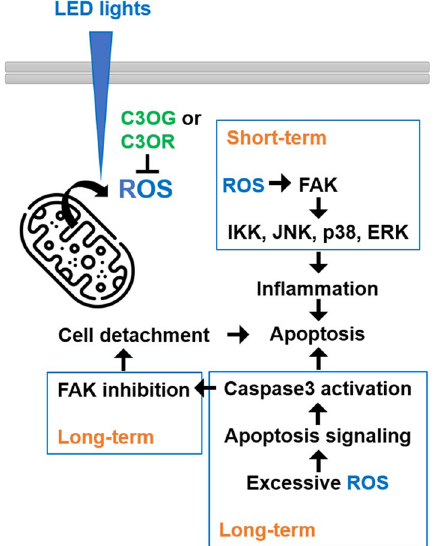
Fig. 7 C3OG and C3OR block blue light‑induced cytotoxicity. Exposure to blue light initiates FAK‑related inflammation signaling events via ROS, triggering apoptotic signaling. Treatment with the anthocyanins C3OG and C3OR effectively suppress the detrimental effects of blue light via a reduction in the generation of